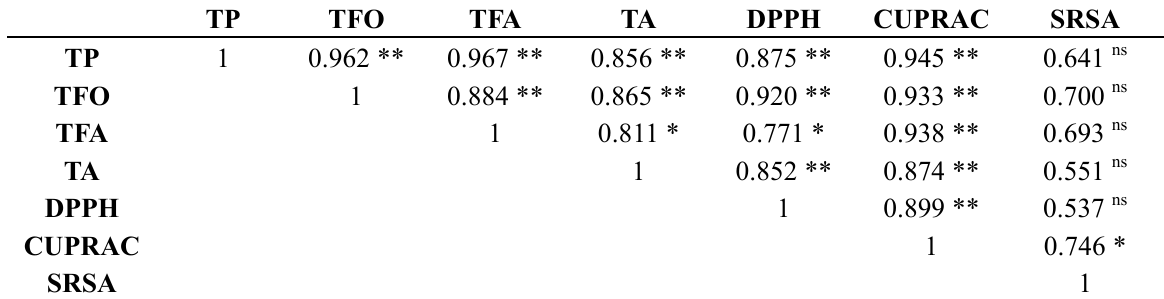
Table 3. Pearson’s correlation coefficients of antioxidant capacity, TP, TFO, TFA and TA in Cabernet Sauvignon and Merlot wines from four different wine grape-growing